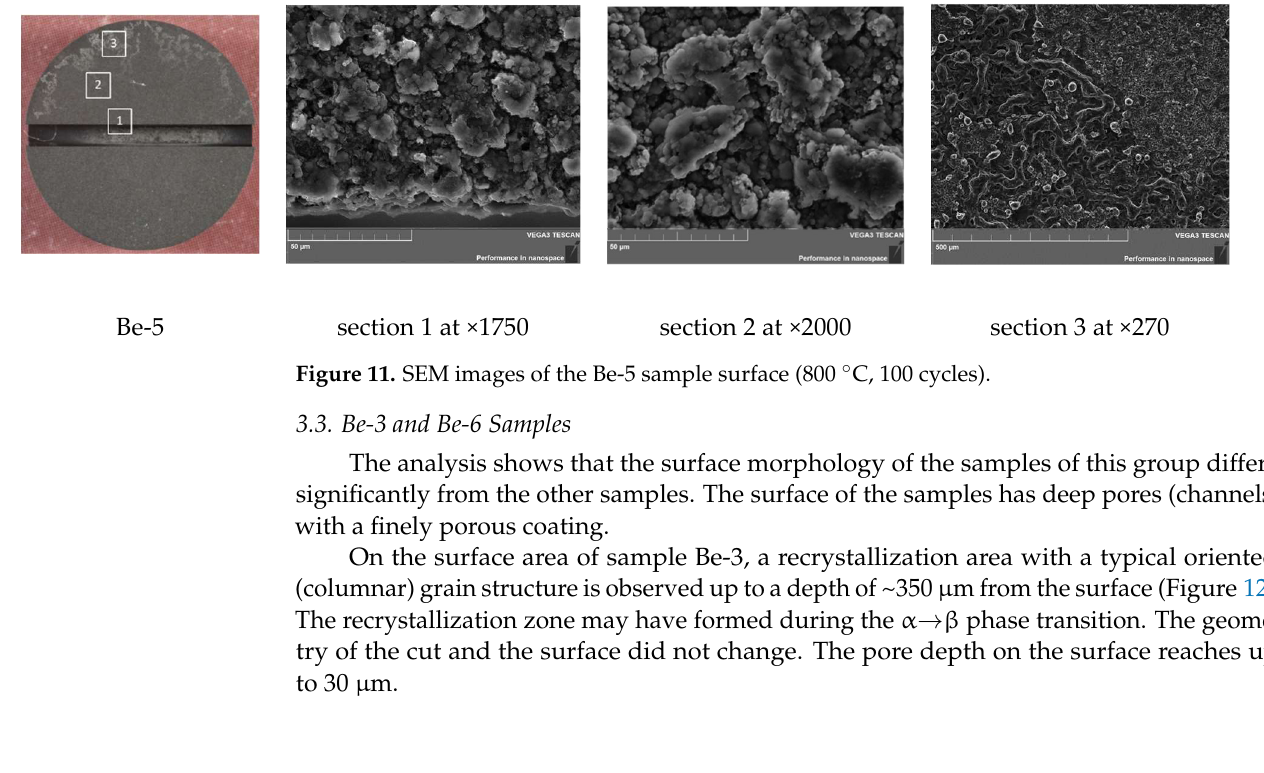
Figure 12. Microstructure of the Be-3 sample cross section (800 °С, 100 cycles). As can be seen in Figure 13, the concentration of pores in sections 1 and 2 of sample Be-3 is the same; and the average value of the pore diameter in these sections is about 20 µm. In the area remote from the center of the sample (Figure 13, section 3), the concentra- tion and the average value of the pore diameter decrease by 10 µm. The surface of the